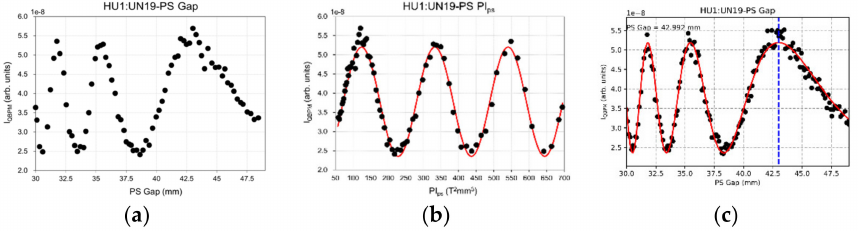
Figure 5. ( a ) Measured data of FEL intensity as a function of the phase-shifter gap, ( b ) convert the abscissa to PI ps , a sine curve fitting, and ( c ) convert the abscissa data to the gap distance and apply the fitting result. In ( c ), the dashed blue line represents one of the optimum phase-matching conditions.